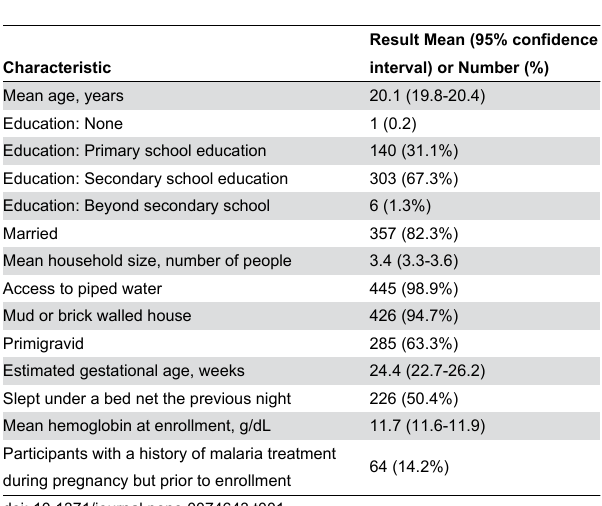
Table 1. Characteristics of study participants at enrollment.